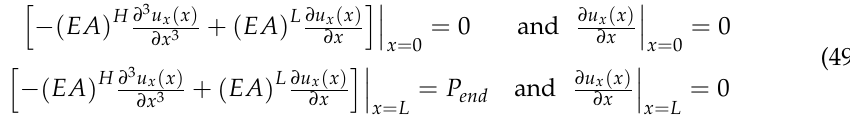
Employing the procedure suggested by He and Lilley [68], the effective Young’s modulus, E ef f , can be obtained in the following fashion: The end displacement, u end , B of the SWCNT–substrate medium system is first computed using the proposed model. Subsequently, Equation (50) is solved for E ef f . B